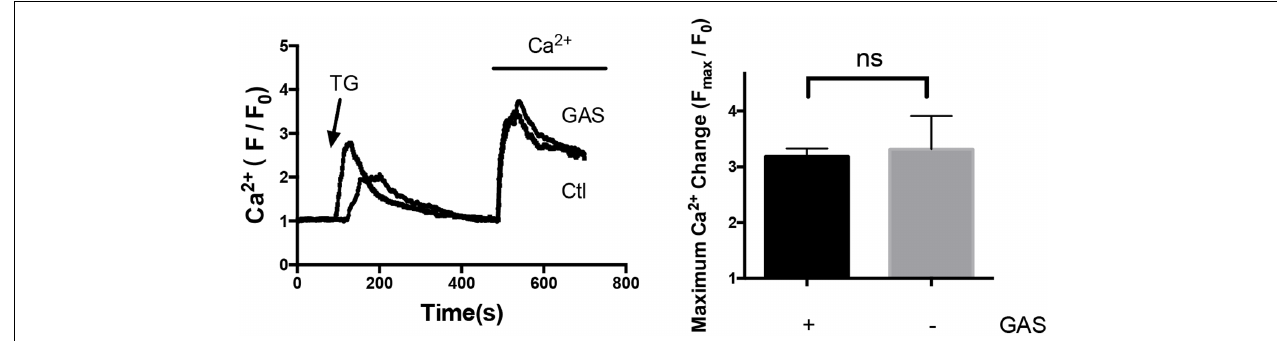
FIGURE 6 | Lack of acute gastrodin action on SOCE in phenylephrine-treated hypertrophic cardiomyocytes. Shown are representative immunoblot images (left) and data summary (right) . The phenylephrine-treated (50 µ mol/L, 48 h) hypertrophic cardiomyocytes were first challenged with 4 µ mol/L TG in a Ca 2 + -free bath, which induced the first Ca 2 + rise, followed by adding back 1 mmol/L Ca 2 + to the bath, which induced the second Ca 2 + rise. The second Ca 2 + rise is due to SOCE. Only SOCE is plotted in the summary chart. When appropriate, 100 µ mol/L gastrodin was applied 5 min before TG. The data are expressed as the mean ± SEM ( n = 5 repeats, > 15 cells per repeat). ns, not